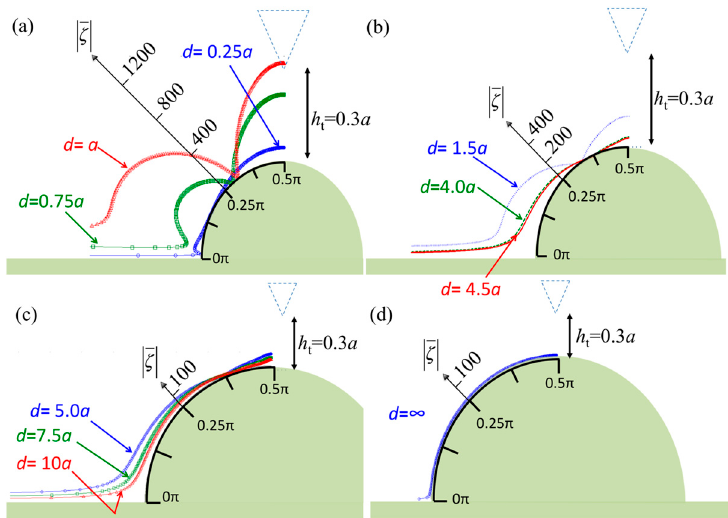
Figure 2. Normalized vorticities in the real part over the surface of the semicircular specimen when the diameter of the semicircle is ( a ) less than the tip width ( d ≤ a ); ( b ) between the tip width and probe width ( a < d < b ); ( c ) greater than the probe width ( b ≤ d ≤ 2 b ); and ( d ) infinity.